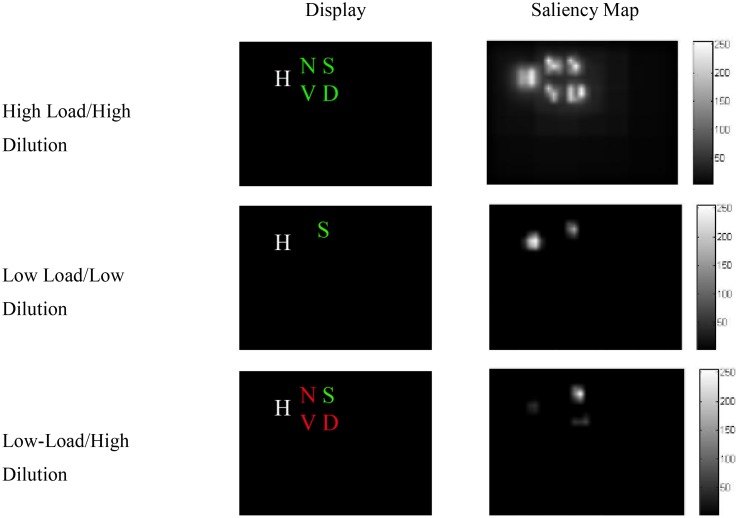
Saliency analysis for the three conditions of Benoni and Tsal (2010).